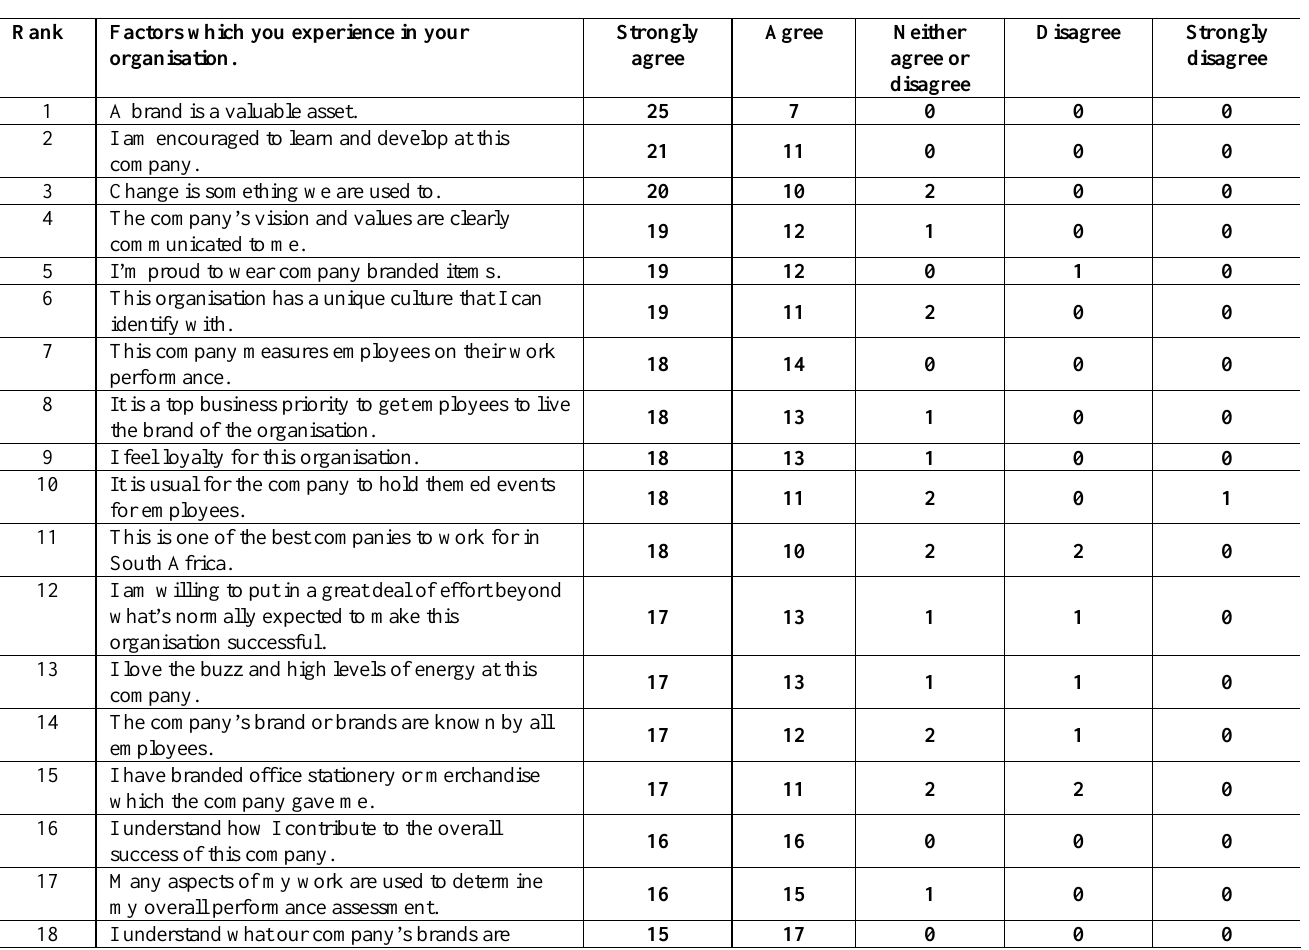
Table 3: Factors present in the organisation